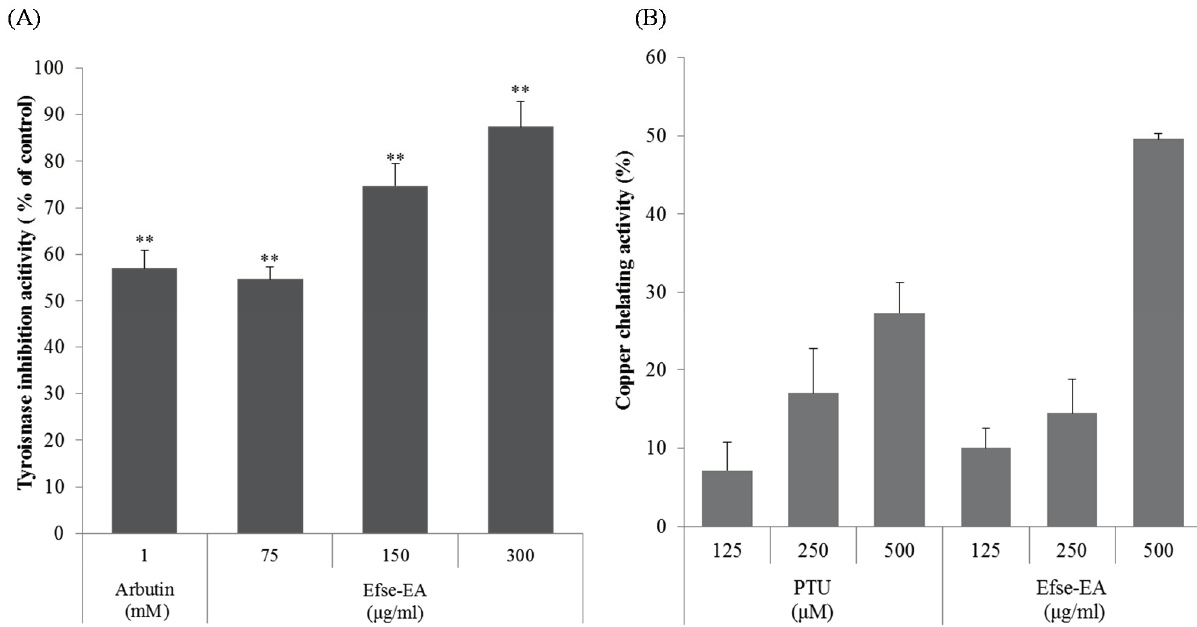
Figure 2. Anti-tyrosinase and copper chelating effects of Efse-EA. Tyrosinase